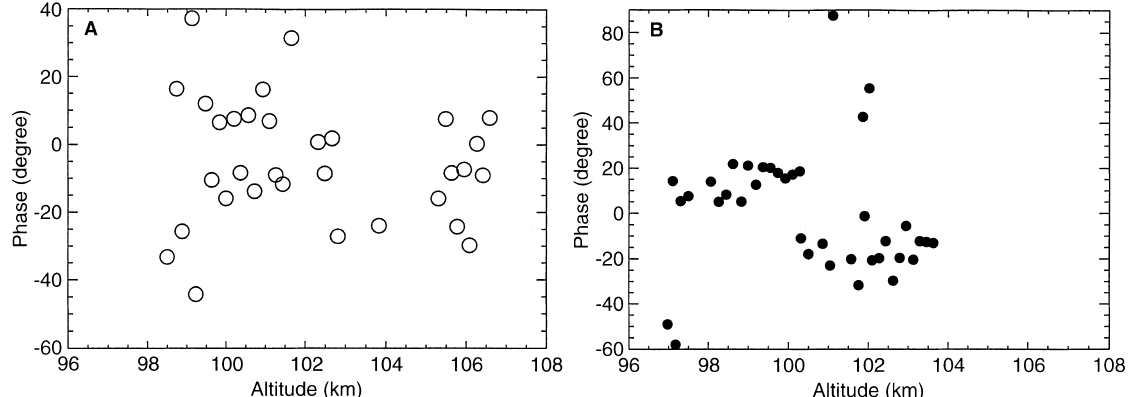
as deviations from the average value determined by ignoring points with large excursion. A refers to upleg, B to